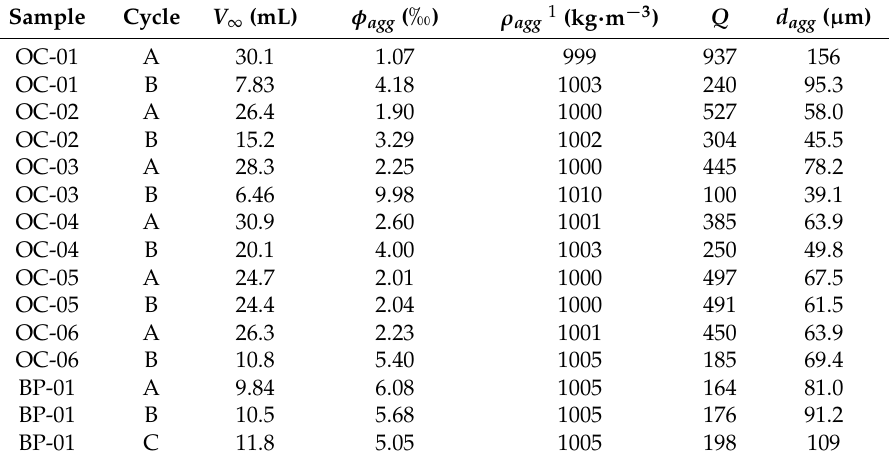
Table 5. Final volumetric parameters and